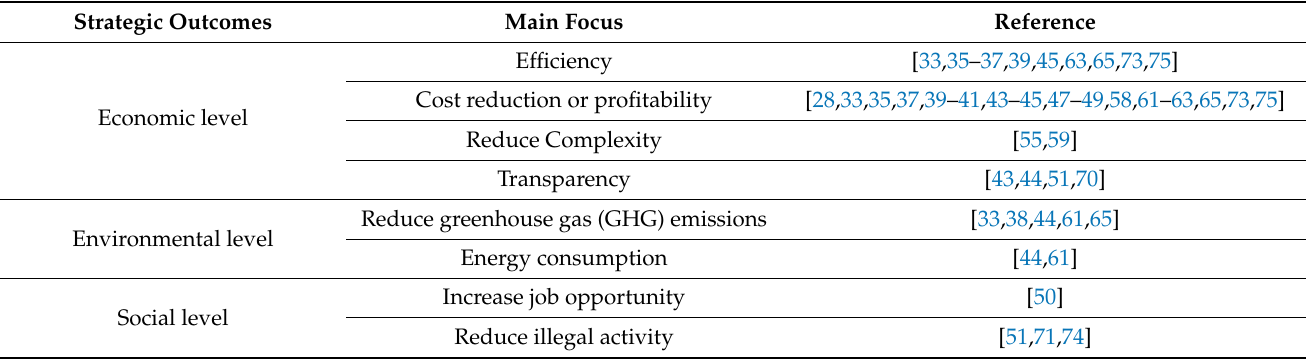
Table 4. Summary of strategic outcomes extracted from the included studies. Strategic Outcomes Main